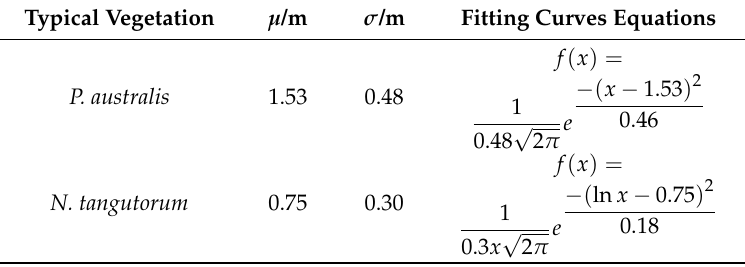
Table 1. Parameters of normal distribution and log-normal distribution fitting curves of P. australis and N. tangutorum